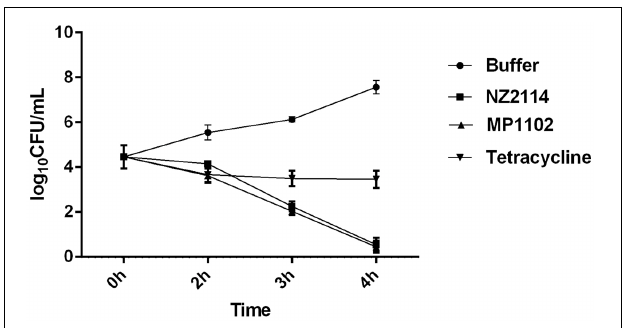
FIGURE 2 | Effects of antimicrobials on concentrations of S. aureus E48 in bovine milk at 37 ◦ C with NZ2114 (100 µ g/mL, squares), MP1102 (100 µ g/mL, triangles), tetracycline (100 µ g/mL, inverted triangles), or the phosphate-buffered saline (PBS) buffer (circles). Each value represents the mean ± SD.